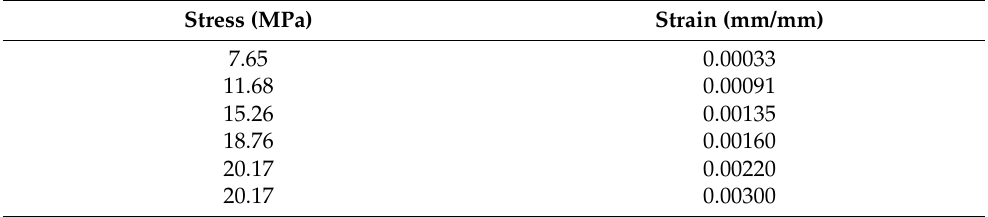
Table 2. Typical stress–strain values for the rubberised concrete defined in ANSYS program [25]. Stress